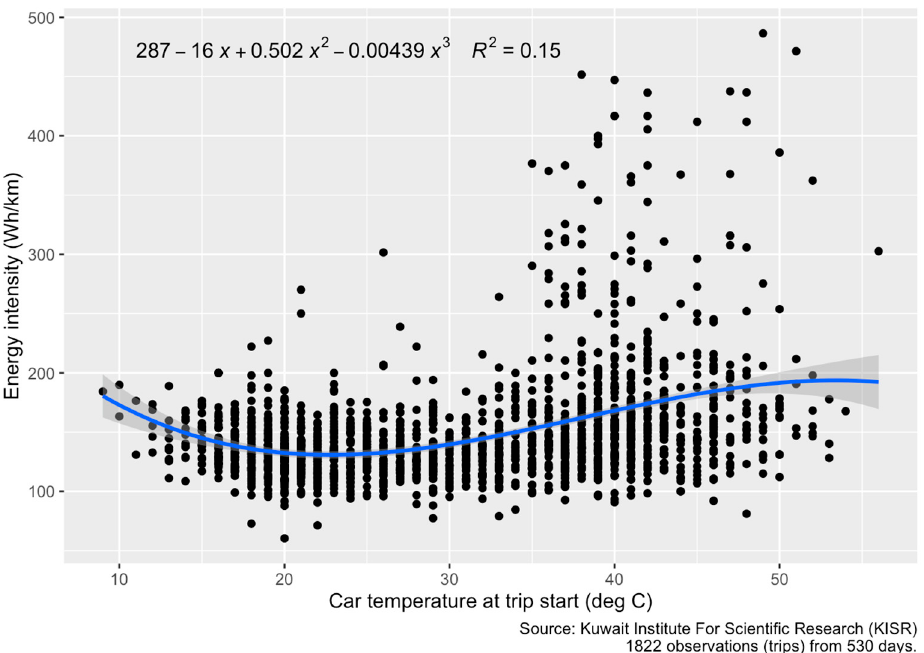
Figure 6. Energy intensity of trips against car temperature at start of journey. Fitted line is a third- degree polynomial.